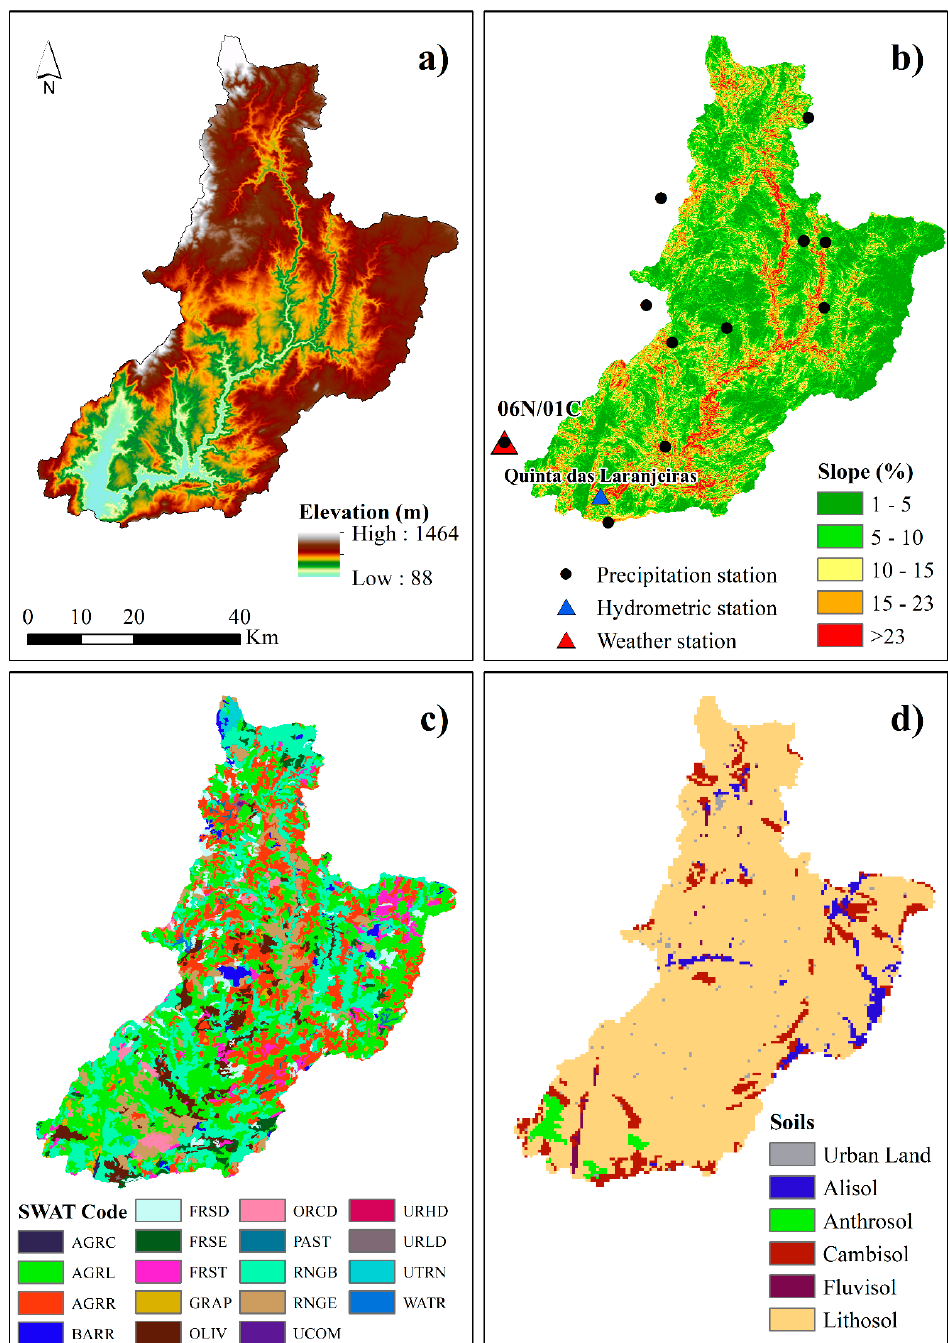
Figure 6. The SWAT (Soil and Water Assessment Tool) input data used for constructing the hydrological model were ( a ) the elevation; ( b ) the slope, meteorological, and hydrometrical data; ( c ) the SWAT codes of land cover classes; and ( d ) the soil types. The SWAT codes are agricultural land—close-grown (AGRC), agricultural land—generic (AGRL), agricultural land—row crops (AGRR), barren (BARR), forest—deciduous (FRSD), forest—evergreen (FRSE), forest—mixed (FRST), vineyard (GRAP), olives (OLIV), orchard (ORCD), pasture (PAST), range—brush (RNGB), range—grasses (RNGE), commercial (UCOM), residential—high density (URHD), residential—low density (URLD), transportation (UTRN), and water (WATR).